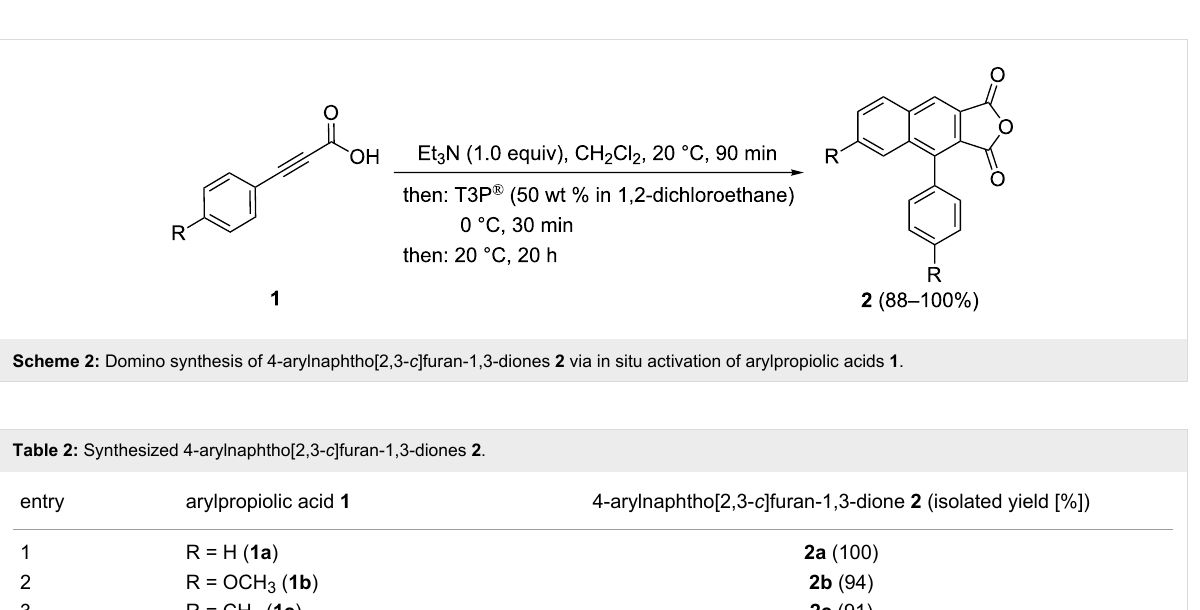
a Without addition of T3P ® .